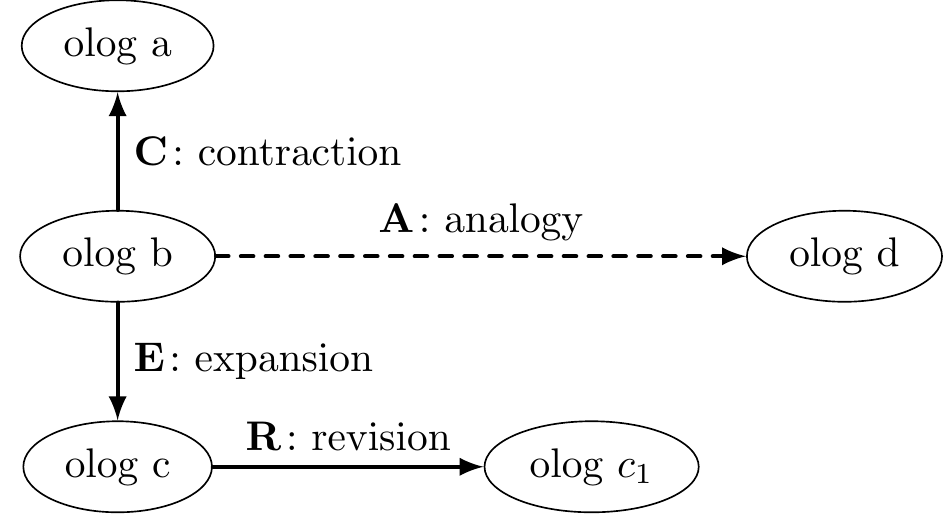
Figure 1. A general idea of the lattice of representation